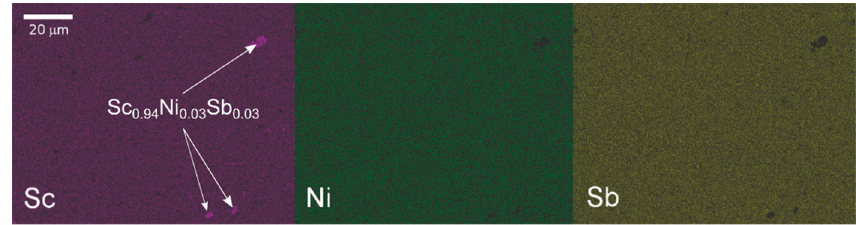
Figure 2. Element mapping of the ScNiSb sample investigated.